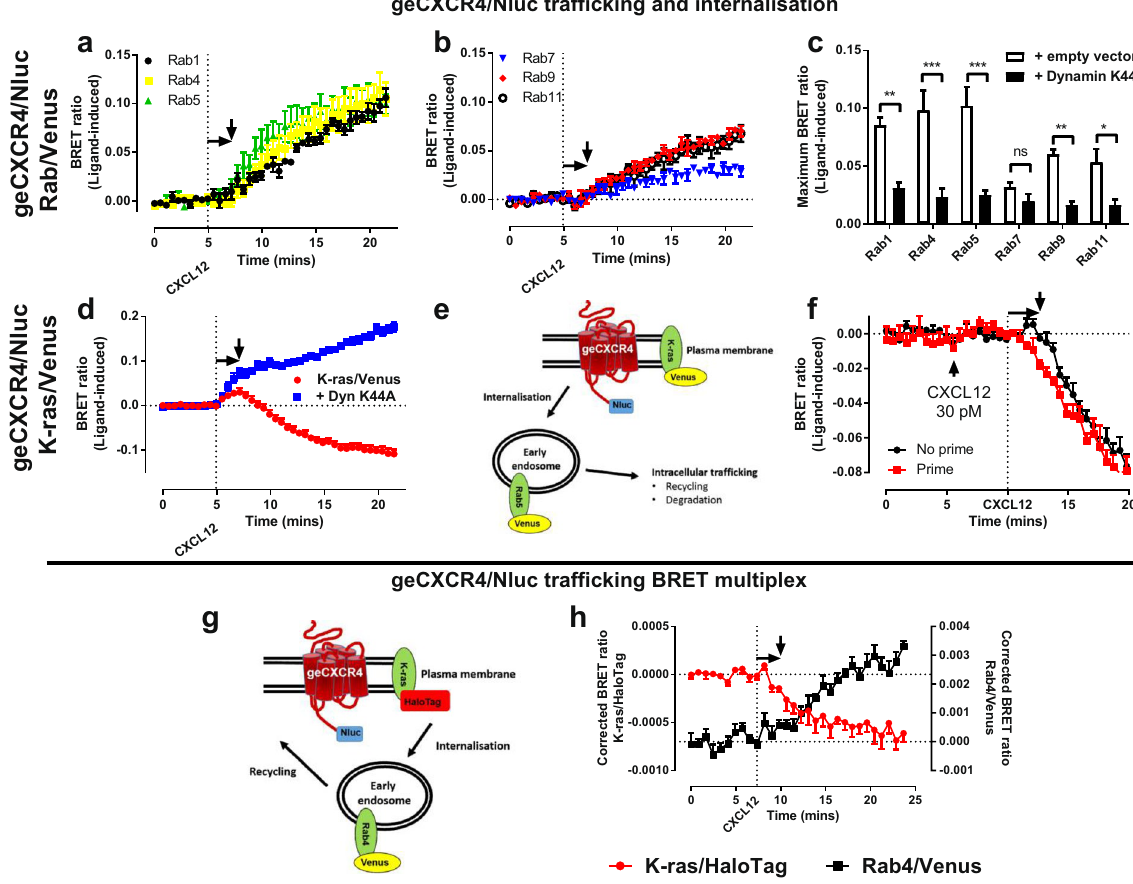
Figure 4. Kinetic profiling of the internalisation and trafficking of genome-edited CXCR4. HEK293FT cells expressing genome-edited CXCR4 fused to Nluc (geCXCR4/Nluc) transiently transfected with cDNA encoding one of the subcellular markers ( a , c ) Rab 1, 4 and 5 ( b , c ) Rab 7, 9, and 11, or the plasma membrane marker K-ras ( d ) fused to Venus in the absence ( a – d ) or presence ( c , d ) of co-expressed dominant-negative dynamin K44A. Internalisation and trafficking was induced by CXCL12 (30 nM) added when indicated. ( e ) Schematic representation of the NanoBRET configuration used in the trafficking assay. ( f ) HEK293FT cells expressing genome-edited CXCR4 fused to Nluc (geCXCR4/Nluc) transiently transfected with cDNA coding for Venus/K- ras were used to determine the effect of receptor priming by CXCL12 (30 pM) on internalisation induced by CXCL12 (30 nM). ( g ) Schematic representation of the NanoBRET multiplex configuration. ( h ) HEK293FT cells expressing genome-edited CXCR4 fused to Nluc (geCXCR4/Nluc) transiently co-transfected with cDNA coding for HaloTag/K-ras and Rab4/Venus were used to study genome-edited CXCR4/Nluc receptor internalisation and trafficking induced by CXCL12 (30 nM) in the same cell using a BRET multiplex assay. ‘BRET ratio (ligand- induced)’ was calculated as described in Methods . Arrows indicate the delay in internalisation following ligand addition. Points represent mean ± S.E.M. of three ( a , b ), four ( h ) or five ( d , f ) independent experiments. Bars ( c ) represent maximum response ± S.E.M. of three independent experiments observed in kinetic time-courses, with empty vector controls obtained from ( a , b ). Statistical analysis by a two-way ANOVA with a Sidak’s post- test for multiple comparisons. ns, not significant; * p < 0.05; ** p < 0.01; *** p <